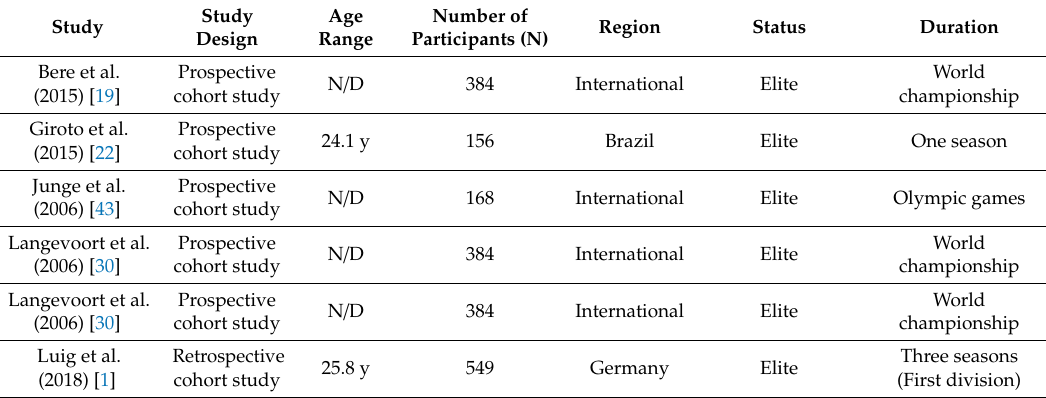
Table 1. Group and intervention characteristics in senior male handball